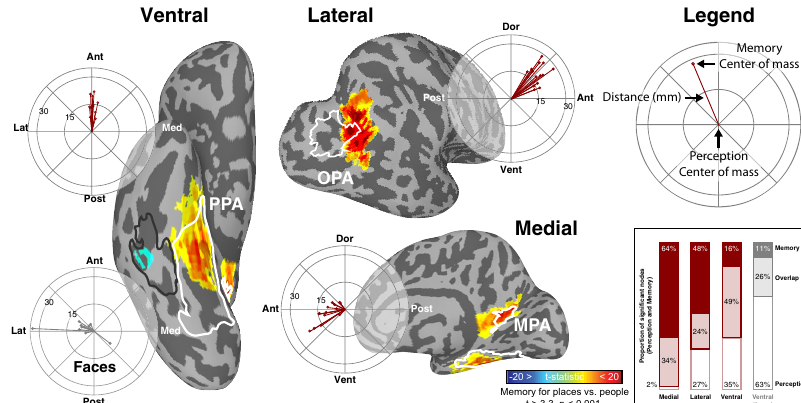
Fig. 1 Distinct topography of place-memory and scene-perception activity in posterior cerebral cortex. In all participants, three place-memory areas were observed, each located signi fi cantly anterior to one region of the scene-perception network. One example participant in Experiment 1 is shown (See Supplementary Fig. 1 and Supplementary Video 1 for thresholded and unthresholded activation maps for all participants ( n = 14)). The participant ’ s scene perception ROIs are outlined in white, and place-memory activity is shown in warm colors. The scene-perception network (parahippocampal place area [PPA], occipital place area [OPA], and medial place area [MPA]) was localized by comparing the BOLD response when participants viewed images of scenes versus with faces (outlined in white, thresholded at vertex-wise p < 0.001). Place-memory areas on each surface were localized in separate fMRI runs by comparing the BOLD response when participants recalled personally familiar places versus people (warm colors, thresholded at vertex-wise p < 0.001). Polar plots: for each cortical surface, the center of mass of place-memory activation was signi fi cantly anterior to the center of mass of scene- perception activation in all participants (all ts > 5, p < 0.001). In contrast, face memory activation was spatially co-localized with the face-selective fusiform face area (FFA) on the ventral surface, and no anterior shift was observed (cool colors, t 9 = 0.1211, p = 0.906). Statistical analyses revealed no difference between the hemispheres, so, for clarity, only right hemisphere is shown. Inset: while the activation during place memory was systematically anterior to activation during scene perception, the spatial overlap between perception and memory activation varied across the cortical surfaces. Note that the axes (posterior-anterior) of each polar plot are aligned to its associated cortical surface. The data in the polar plot re fl ects distance in